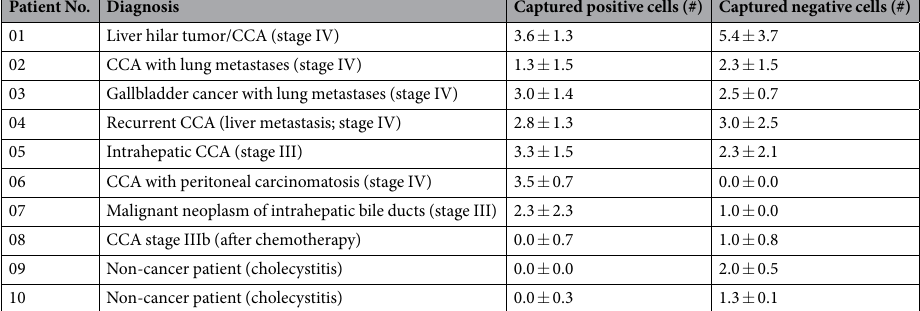
Table 1. Number of cholangiocarcinoma (CCA; “positive”) and non-CCA (“negative”) cells captured from two technical replicates (i.e., bile aliquots) from each of eight CCA patients with the on-chip CCA diagnostics system. Error bars represent standard